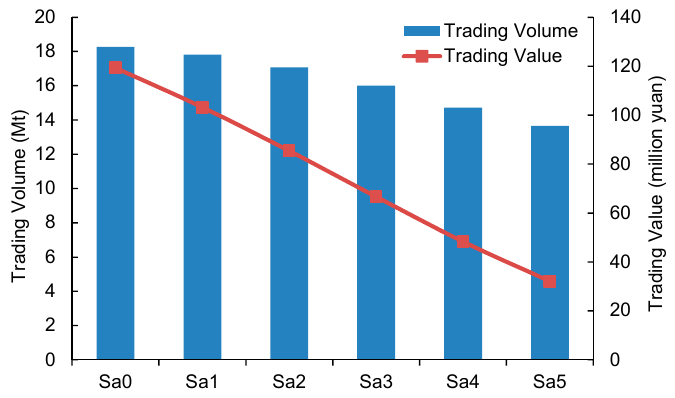
Figure 6. Total carbon trading volume and value under different scenarios.